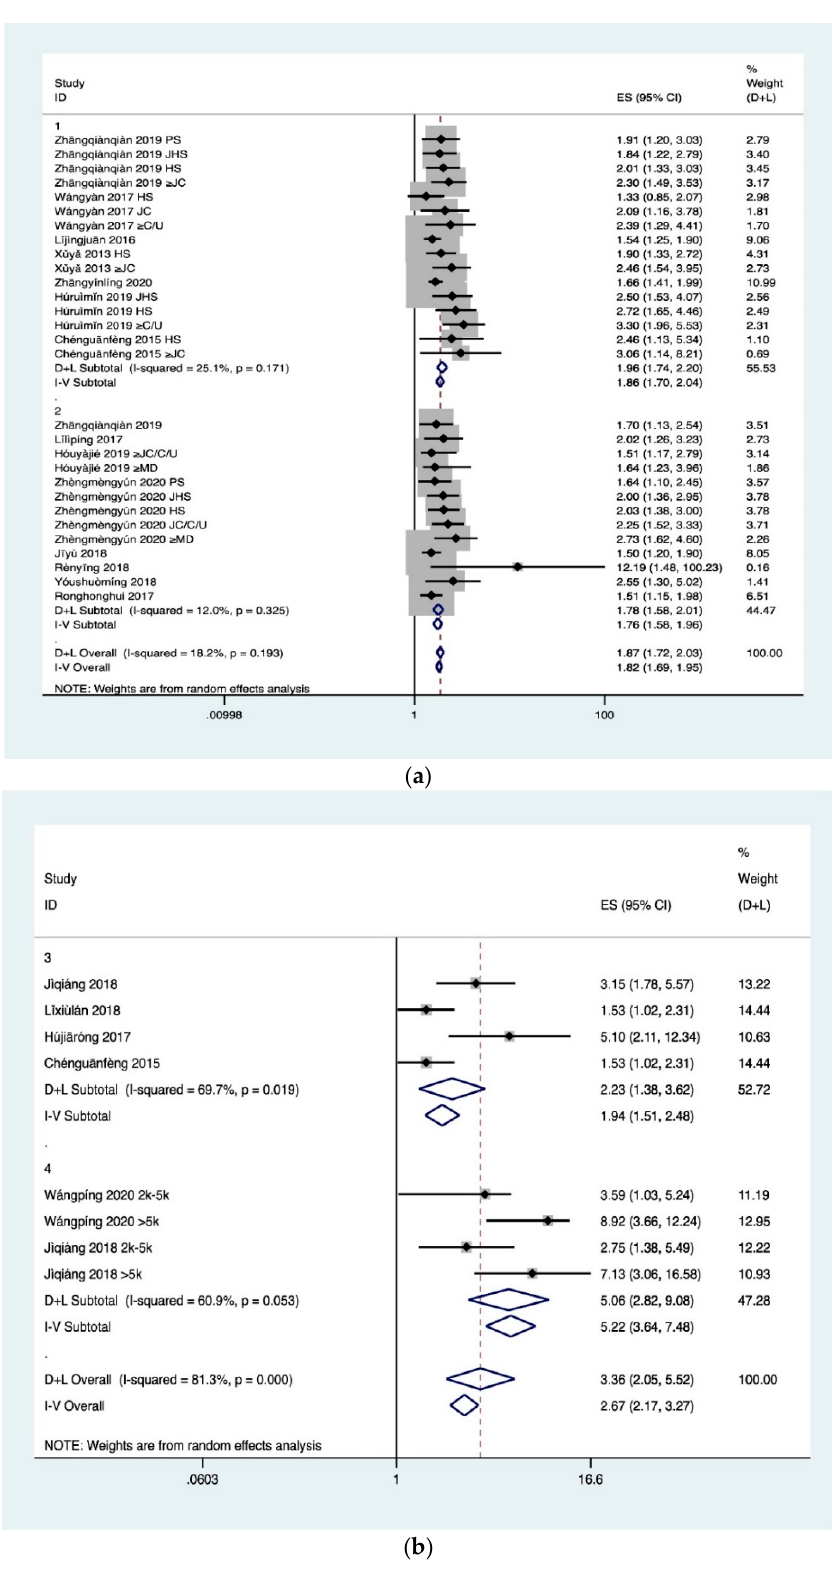
Figure 4. ( a ) Meta for FE. 1: father’s education level; 2: mother’s education level; HS: high school; JHS: junior high school; PS: primary school; JC: junior college; college; C: college; U: university; MD: master’s degree. ( b ) Meta for FE. 3: single-child; 4: family income; 2k: two thousand yuan; 5k: five thousand yuan.